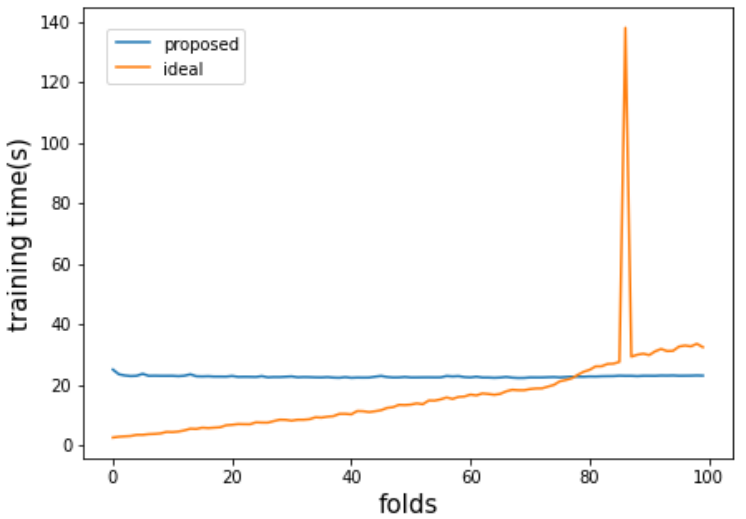
Figure 8. Training time per unit data input of the proposed method and the ideal method when the size of the pure dataset is 40,000.